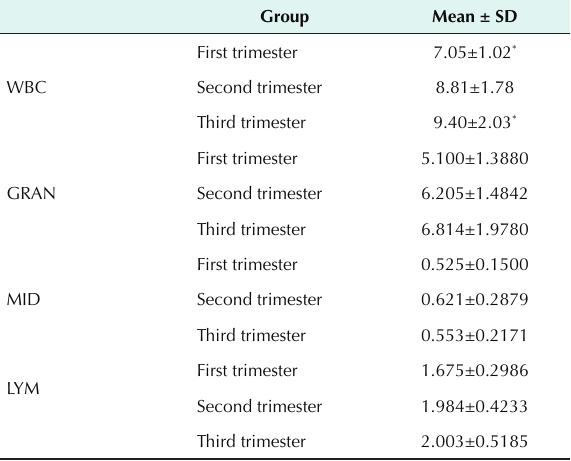
Table 3. Leukogram in the 1 st , 2 nd , and 3 rd Trimester in a Normal Pregnancy Group